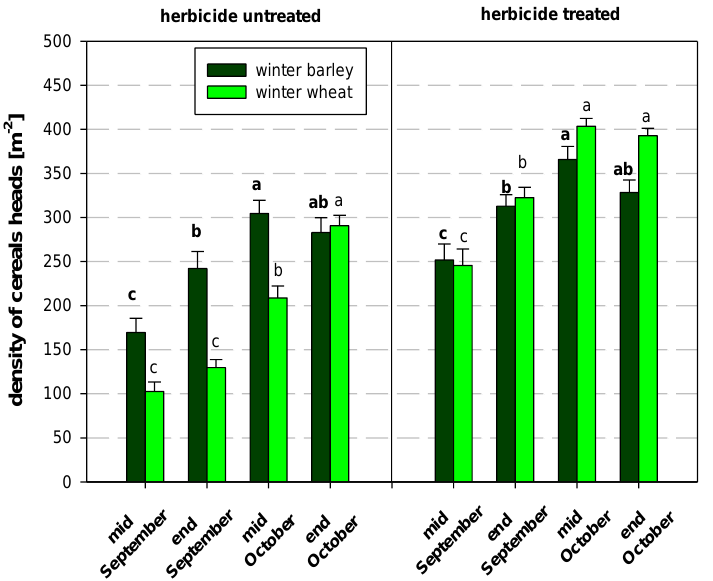
Figure 5. Density of cereal heads in herbicide-untreated and herbicide-treated areas [m −2 ] in winter barley and winter wheat depending on sowing date, error bars = standard error, different letters indicate significant differences between sowing date or herbicide treatment (bold letters: winter barley), p ≤ 0.05, Tukey -HSD-Test. A higher grain yield depression for early sowing dates was observed for winter wheat than for winter barley (Figure 6). The lowest yields were harvested from cereals sown in mid-September. For both crops, highest yield was achieved for mid-October sown treatments. The comparison between the herbicide treatments showed no appreciable dif- ferences in grain yield for both crops.